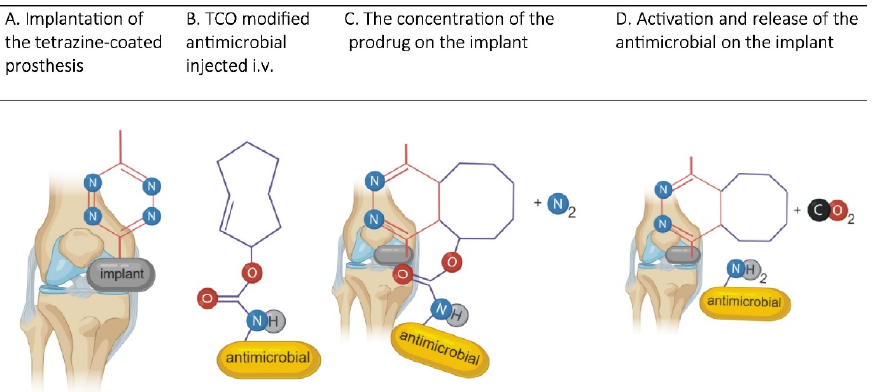
Figure 8. Daptomycin conjugation to a medical-implant coating through bio-orthogonal click chemistry based on tetrazine and trans -cyclooctene (TCO). Reprinted with permission from Ref. [146]. Copyright 2020 Elsevier.